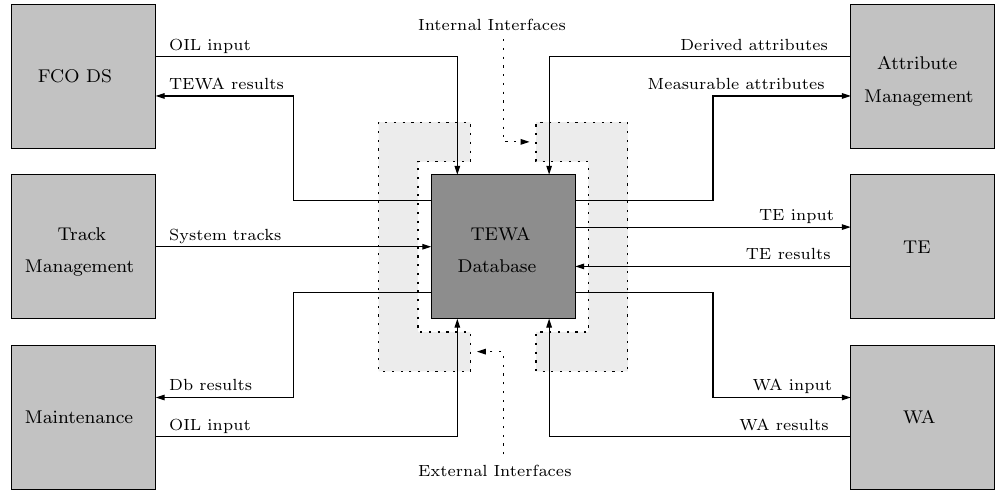
Figure 6: Dataflow between the internal processes, external processes and the database of a TEWA